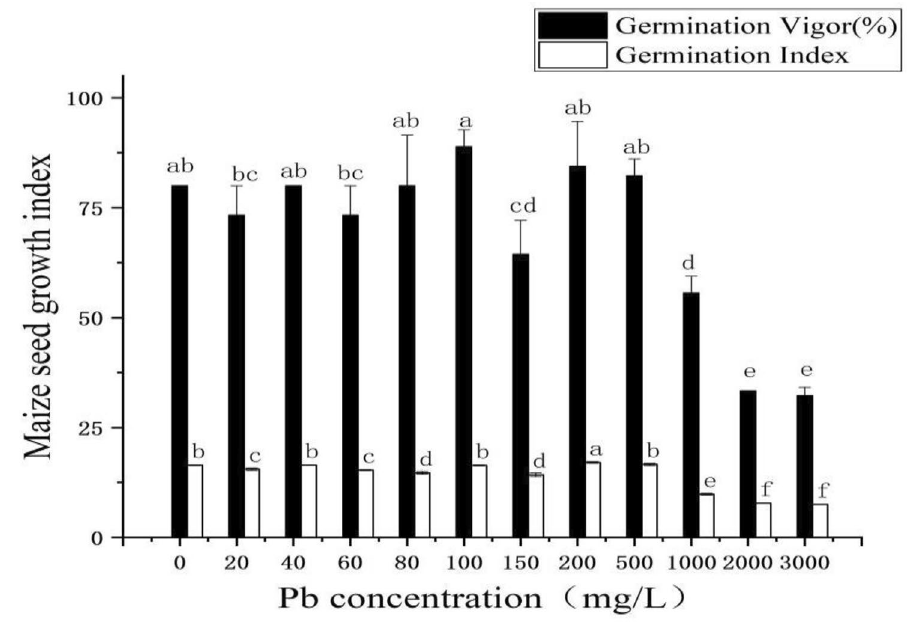
Fig. 3 Seed vigor under the dif- ferent Pb